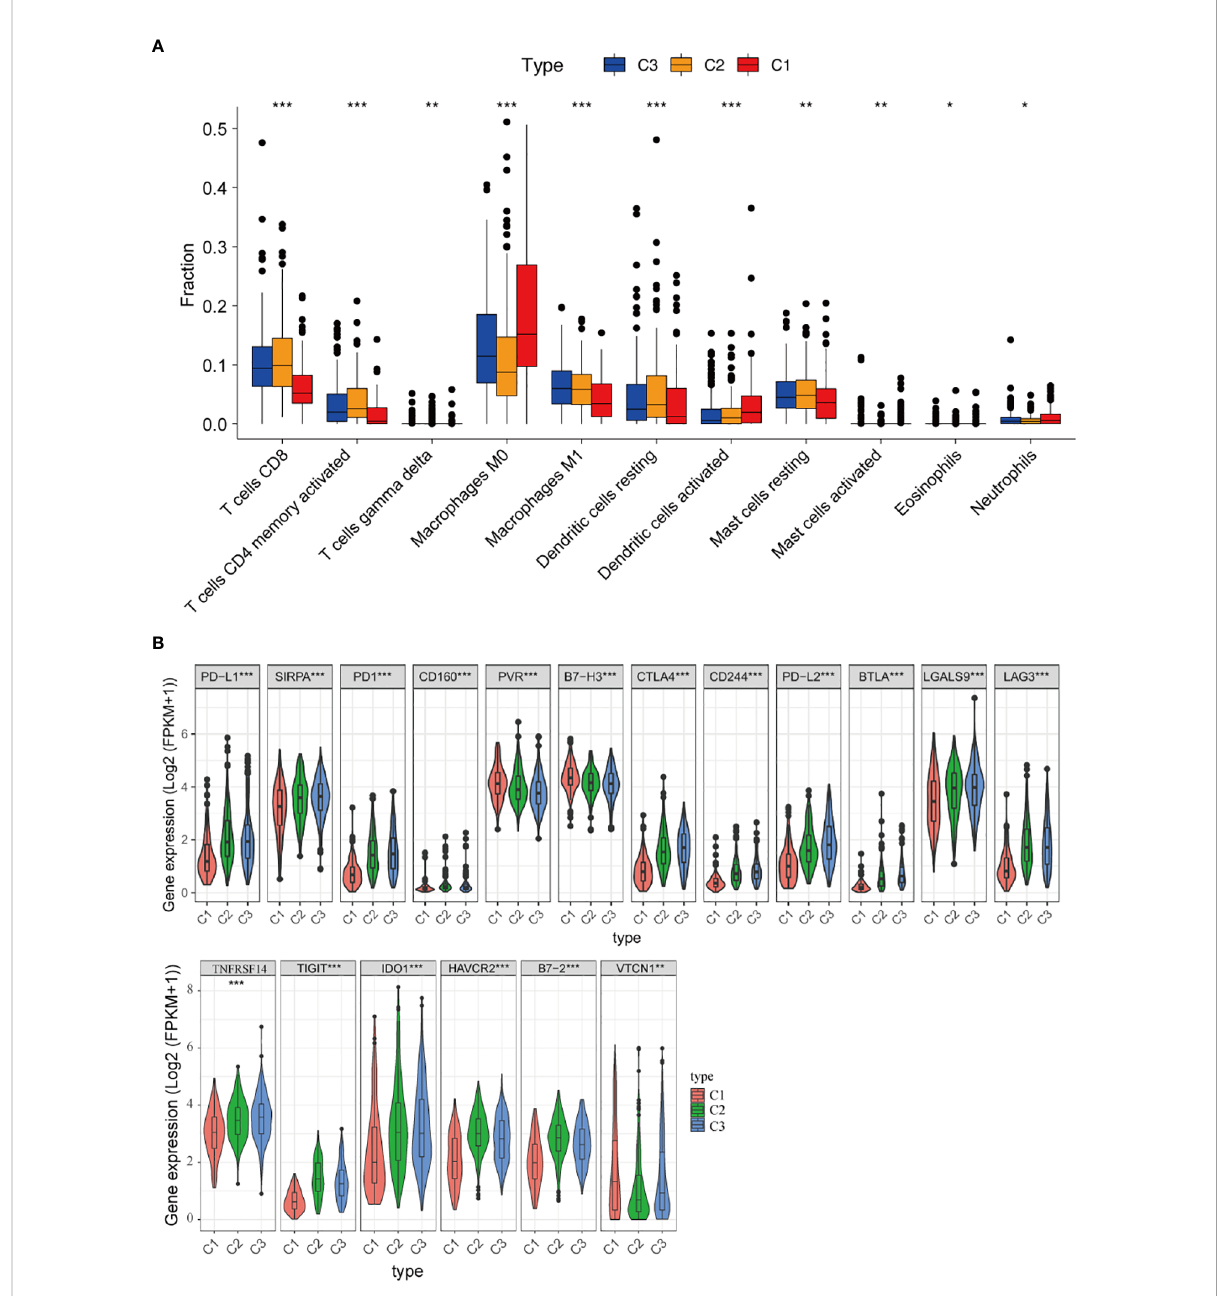
FIGURE 4 Immune microenvironment of three subtypes. (A) Comparison of the distribution of immune cells in three clusters; (B) The expression of immune checkpoint-related genes in three clusters. *, P < 0.05; **, P < 0.01 and ***, P <